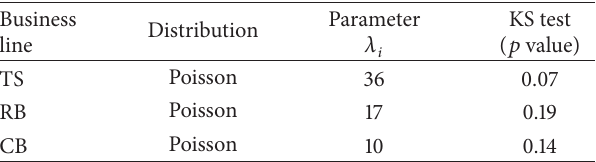
Table 2: The parameters of loss frequency distribution for different business lines.